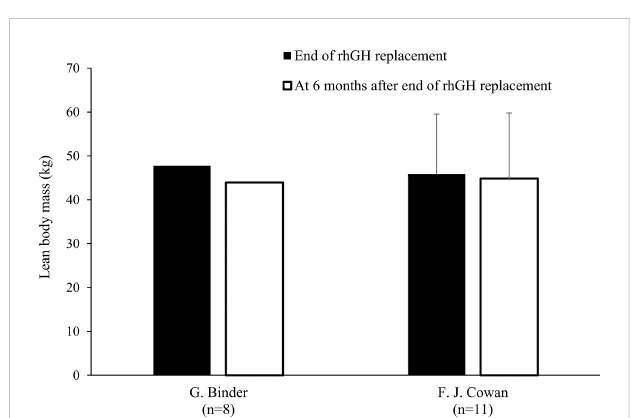
FIGURE 6 Lean body mass (mean kg with standard deviation [if available]) at the end of rhGH replacement and 6 months later in patients with GHD a (17, 19). a Binder et al. enrolled patients with severe disease (stimulated growth hormone <16 ng/mL and by insulin-like growth factor-1 < – 1.90 standard deviation score). GHD, growth hormone de fi ciency; rhGH, recombinant human growth